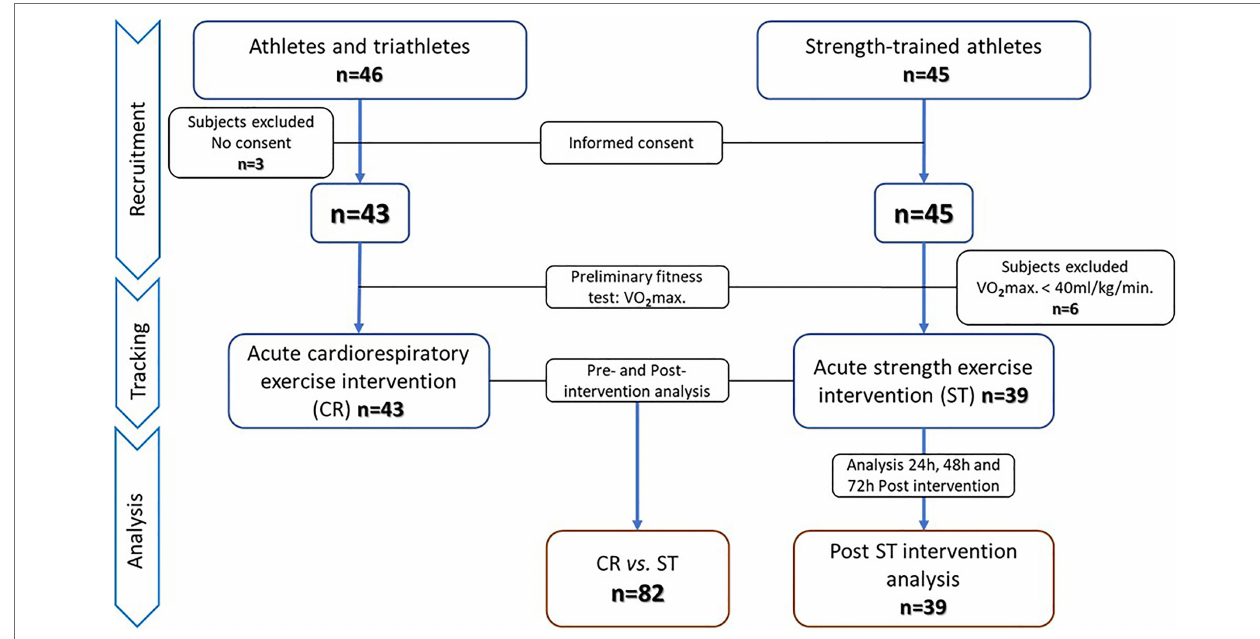
FIGURE 1 | Flow chart detailing the recruitment, tracking, and analysis of the study